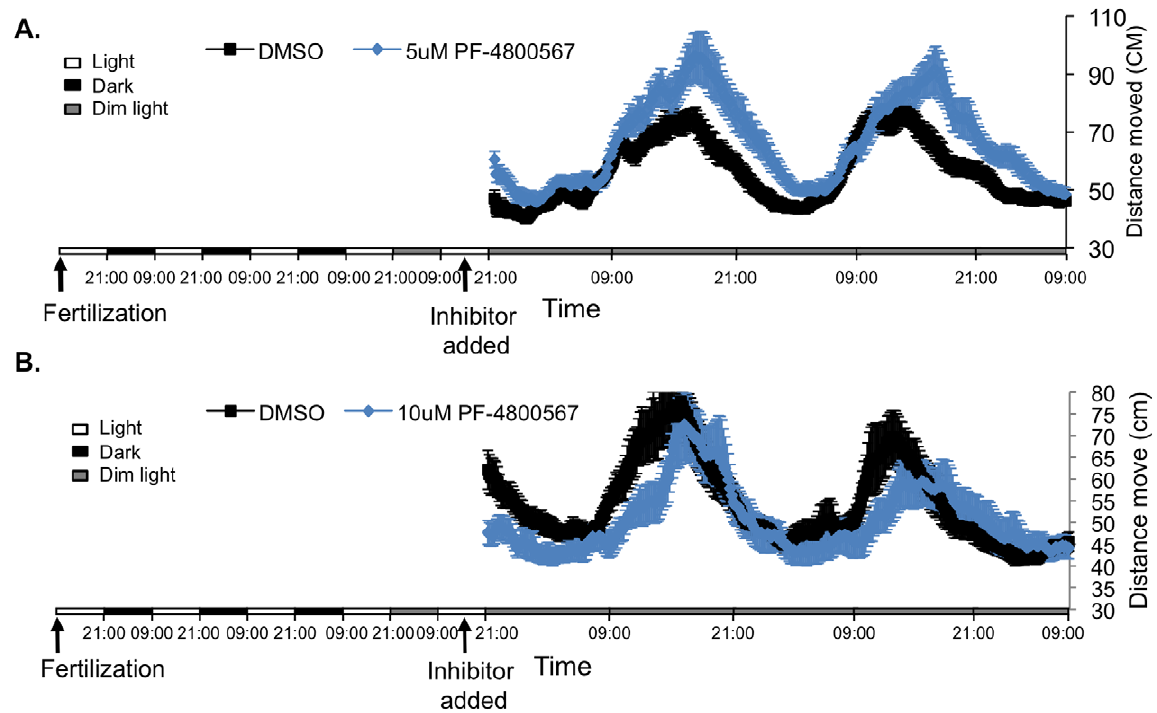
Figure 4. CK1 e inhibition does not affect clock-controlled rhythmic locomotor activity in zebrafish larvae. Locomotor activity of zebrafish larvae was detected by the DanioVision observation chamber. Distance moved (cm) is plotted on the y-axis and time (hours) on the x-axis. The horizontal bars represent the lighting conditions before and during the experiment. White boxes represent light, black boxes represent dark and grey boxes represent dim light. The PF-480567 inhibitor was added to the water at two different concentrations, A-5 m M and B-10 m M (blue lines). Control larvae were treated with DMSO at the same concentrations (black lines). CK1 e inhibition did not affect the locomotor activity rhythm, but did have a slight phase shifting